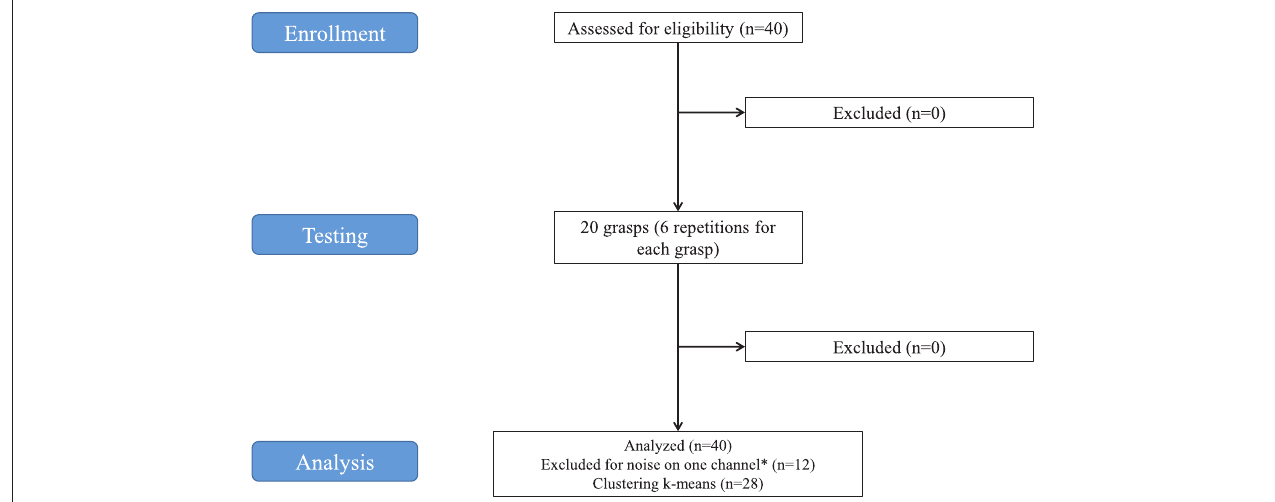
FIGURE 1 | Study flowchart. *Twelve subjects were excluded from analysis because noise was found on at least one of the SEMG channels in some grasps. The decomposition algorithm applied to extract synergies would be influenced, even in case of removal of the affected channels from the analysis. Consequently, 12 subjects were discarded.